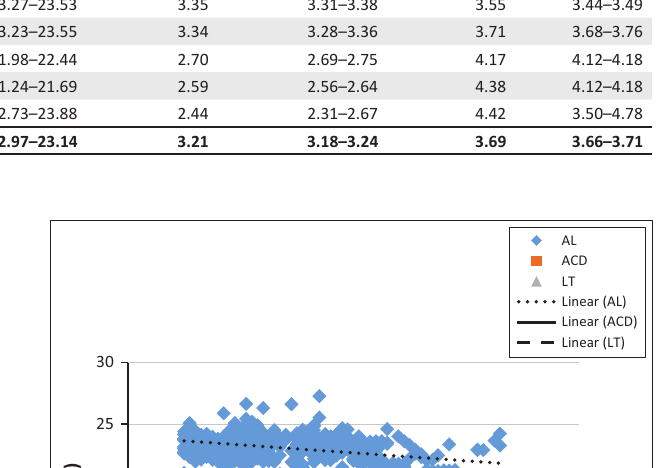
TABLE 3: The association of axial length, anterior chamber depth and lens thickness with age and gender according to univariate linear regression. Ocular biometry variable